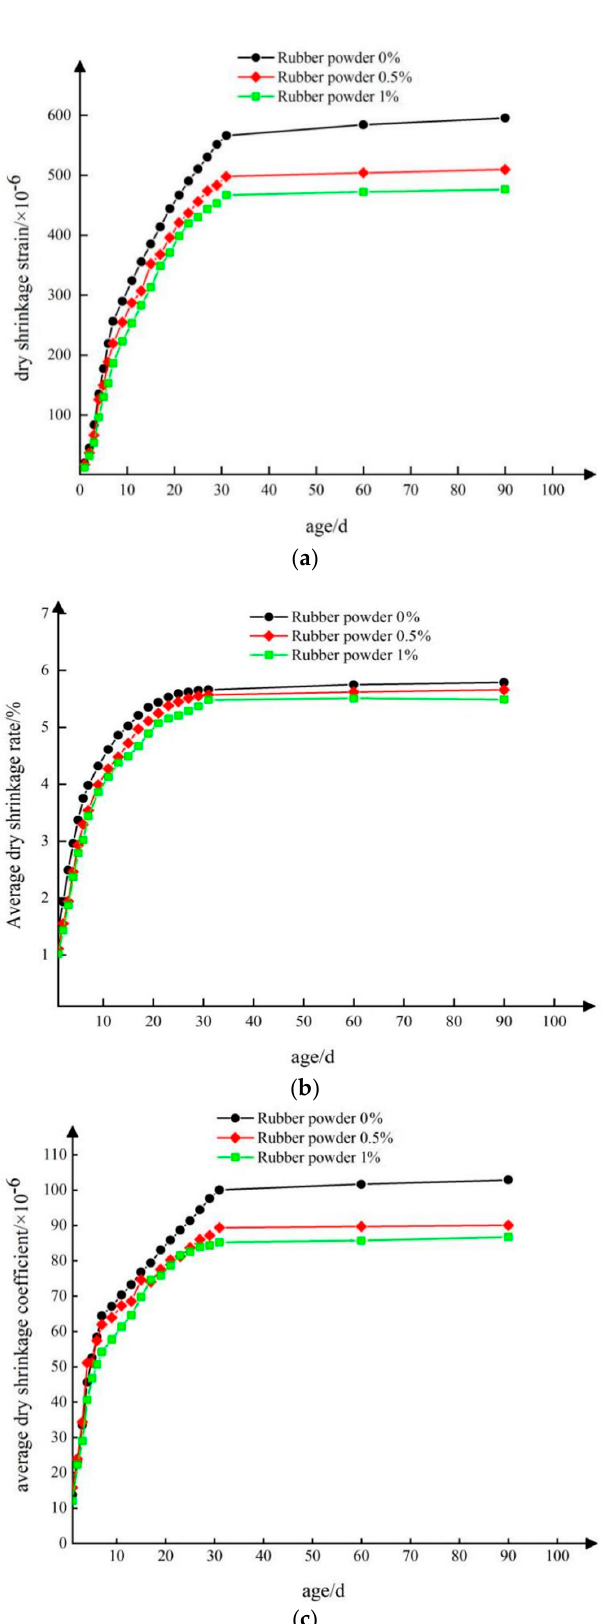
Figure 17. Curve diagram of relationship between dry shrinkage strain ( a ), average water loss rate ( b ), average dry shrinkage coefficient ( c ), and